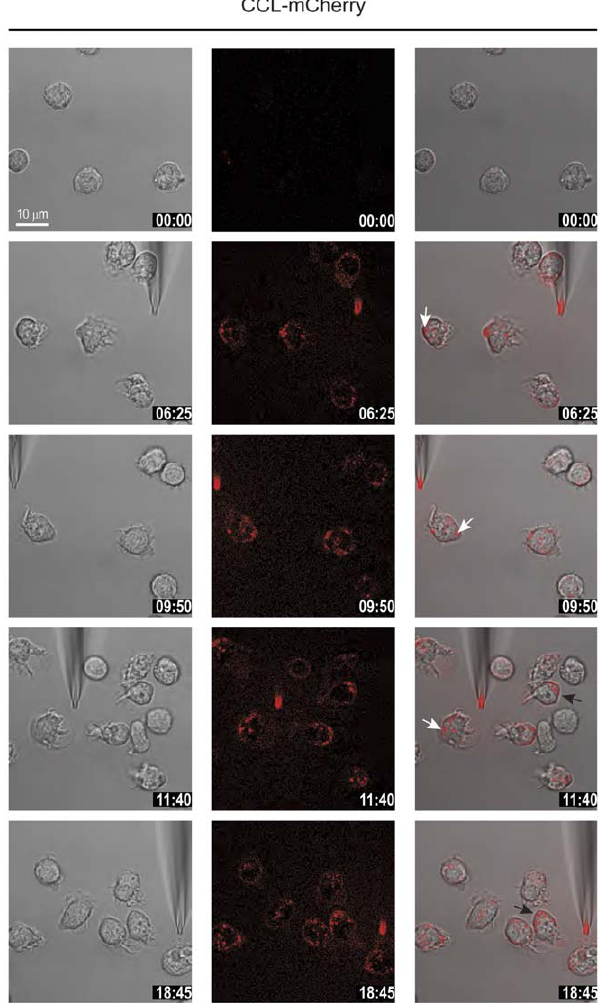
Figure 6. CCL2-mCherry uptake continues after reversal of polarization. Selected frames from time-lapse video microscopy (Movie S7) of migrating human monocytes recorded at 37 u C. The micropipette was dispending 100 nM CCL2-mCherry with constant backpressure. The position of the needle was changed several times during recording. Left panels phase images, middle panels CCL2- mCherry (ex 594 nm/em 620–680 nm), and right overlay. Arrows indicate the localization of internalized CCL2-mCherry in two represen- tative cells upon reverting their axis of polarization. Time stamps are indicated in